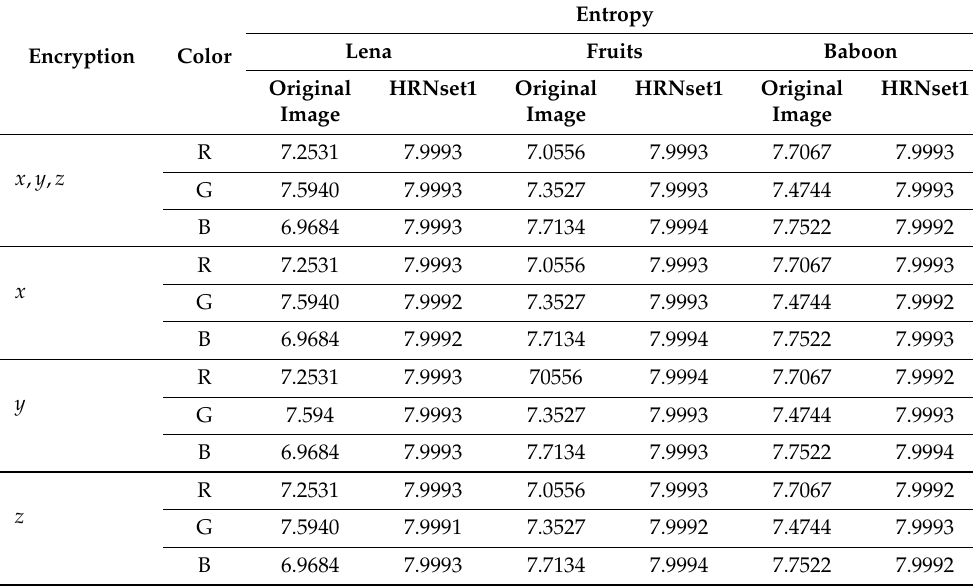
Figure 15. Histograms of the Lena image encrypted using the set of values HRNset1. Original images on the left and the R, G and B encryption on the right. The entropy is evaluated by (11) using HRNset1, and using 8 bits ( N = 8), Table 15 shows the entropies for the three images (Lena, Fruits and Baboon). Table 15. Entropies of the original Lena, Fruits and Baboon images and the encrypted ones using the sets of values HRNset1 from Table